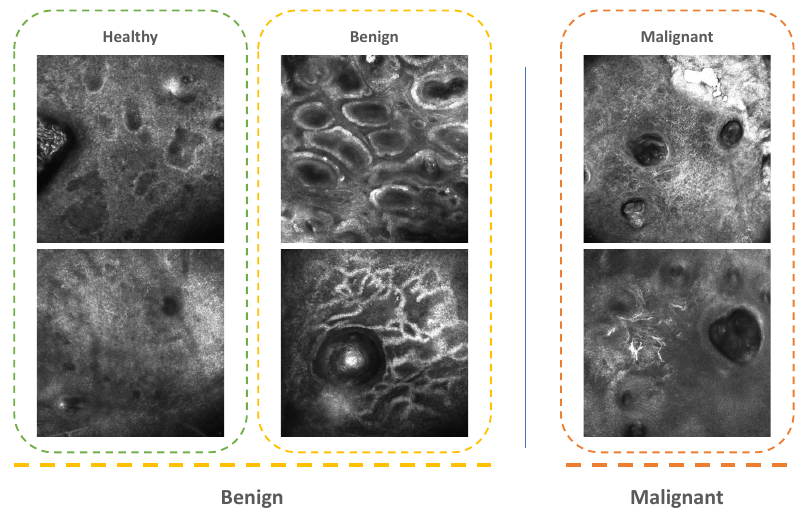
Figure 2. This figure shows several examples of images related to the three different types of tissue: namely “healthy”, “benign” and “malignant”. For this work purpose, the “healthy” and “benign” labels are merged under the “benign” label.